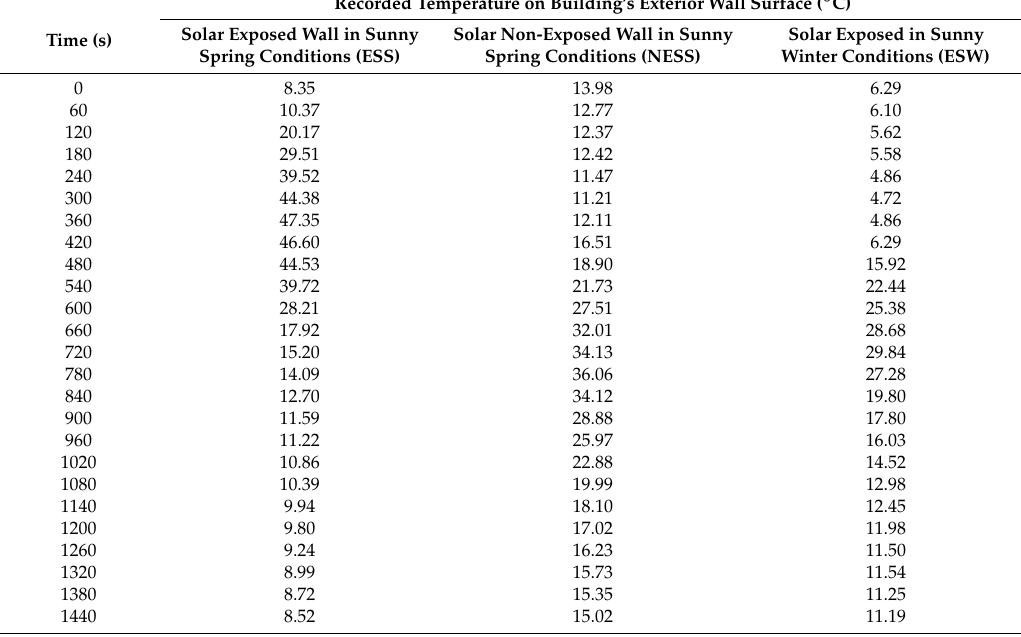
Table A1. Actual recorded temperature